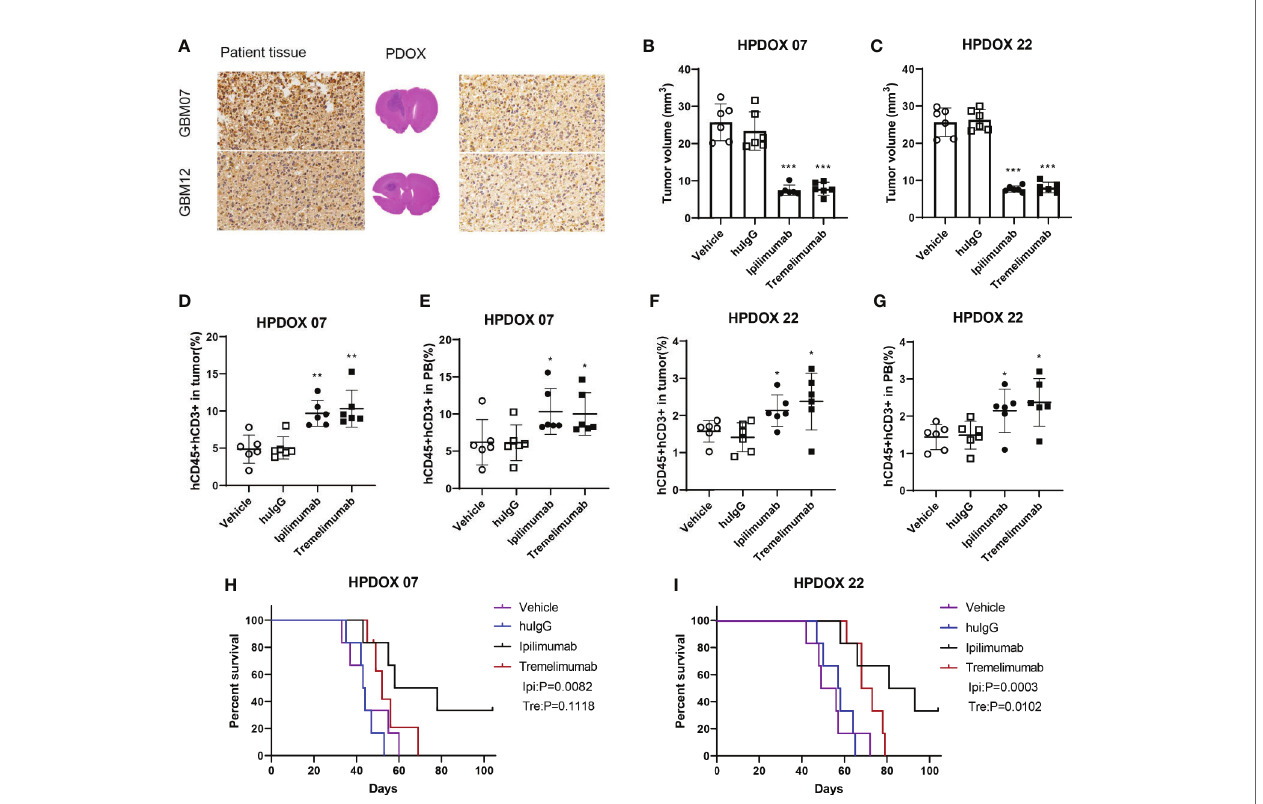
FIGURE 3 | Evaluating the antitumor effect of anti-CTLA4 monoclonal antibodies in HPDOX. (A) IHC analyzes anti-CTLA4 in HPDOX 07, HPDOX 22; Scale bar: 20 m m (sides)/1,000 m m (middle). (B, C) Tumor volume of GBM xenograft in mice treated with Vehicle, huIgG, ipilimumab, and tremelimumab. (D – G) The population of T cells in GBM tissues (D, F) and peripheral blood (E, G) in mice treated with Vehicle, huIgG, ipilimumab, and tremelimumab. (H, I) The survival data of the HPDOX 07, and HPDOX 22 was presented after the treatment respectively. There were six mice in each group. Data were represented as mean ± SD. * P < 0.05, ** P < 0.01, *** P < 0.001.